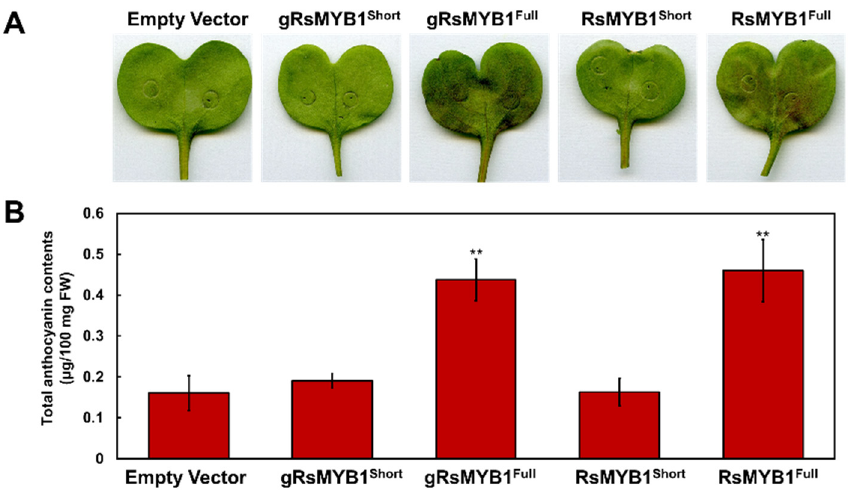
Figure 6. Functional analysis of RsMYB1 Short and RsMYB1 Full for anthocyanin biosynthesis. ( A ) Transient Agrobacterium-mediated infiltration assay of constructs expressing RsMYB1 in radish cotyledons. ( B ) Anthocyanin contents in transiently infiltrated radish cotyledons shown in A. Results are mean values ± SD from three independent biological replicates. ** p < 0.01, as determined by Student’s paired t -test relative to the empty vector.